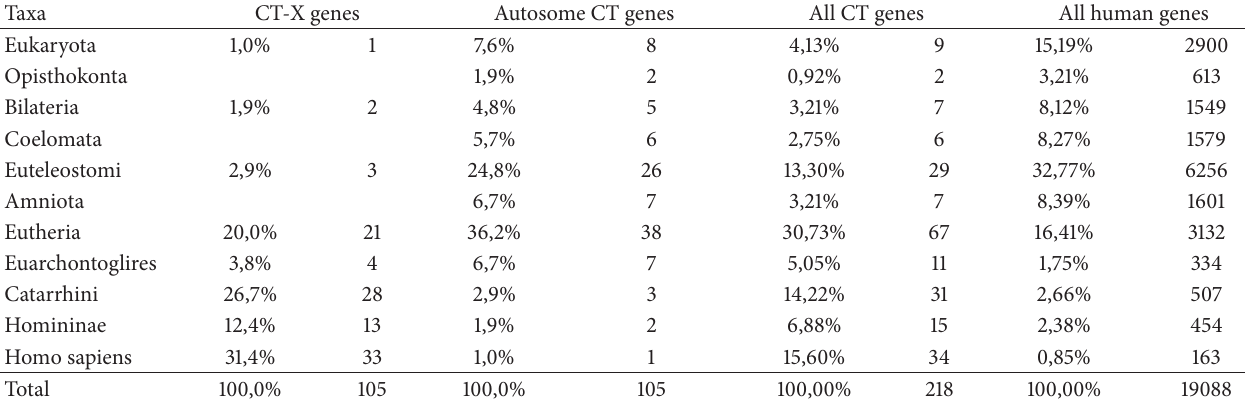
Table 2: CT-X genes, autosomal CT genes, all human CT genes, and all annotated human genes with orthologues originated in different taxa of H. sapiens lineage.